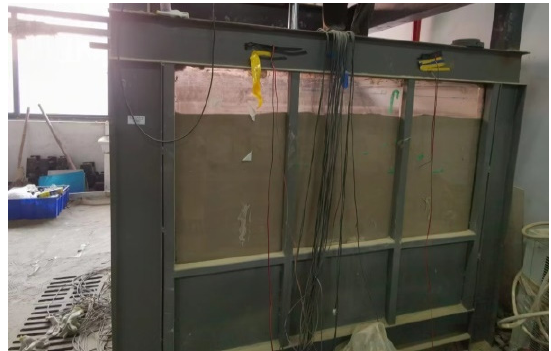
Figure 2. Model box.